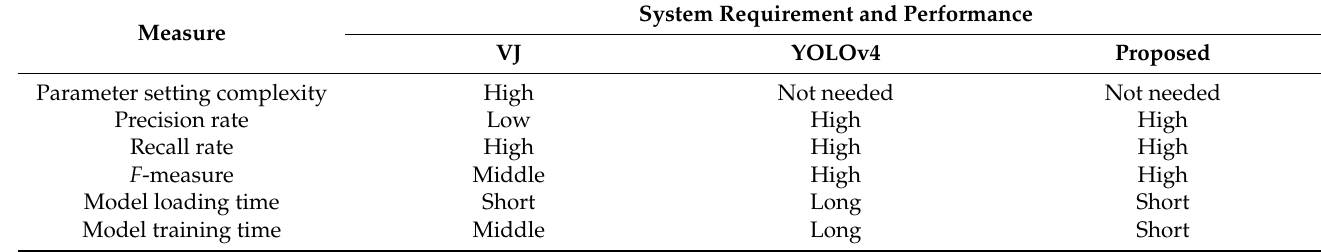
Table 4. System comparisons among the VJ algorithm, YOLOv4 network, and the proposed app.